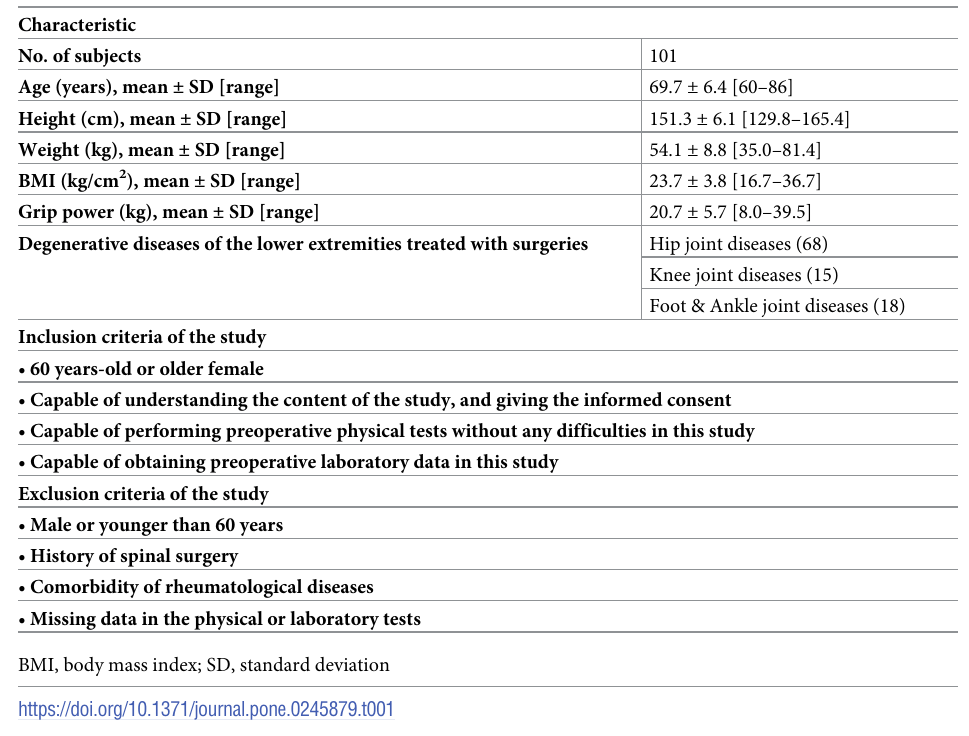
Table 1. Patient characteristics and inclusion/exclusion criteria of the